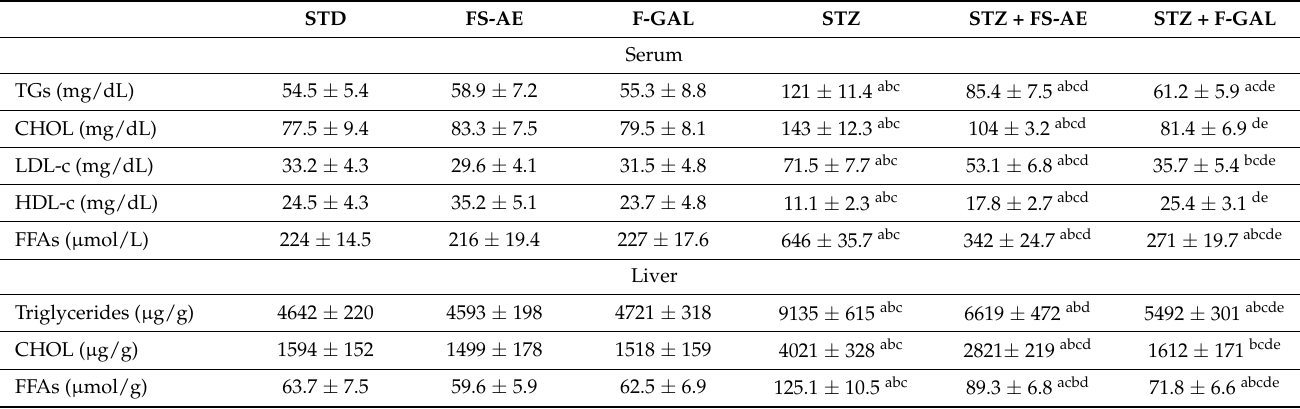
Table 3. Serum and hepatic lipid profile in all groups of